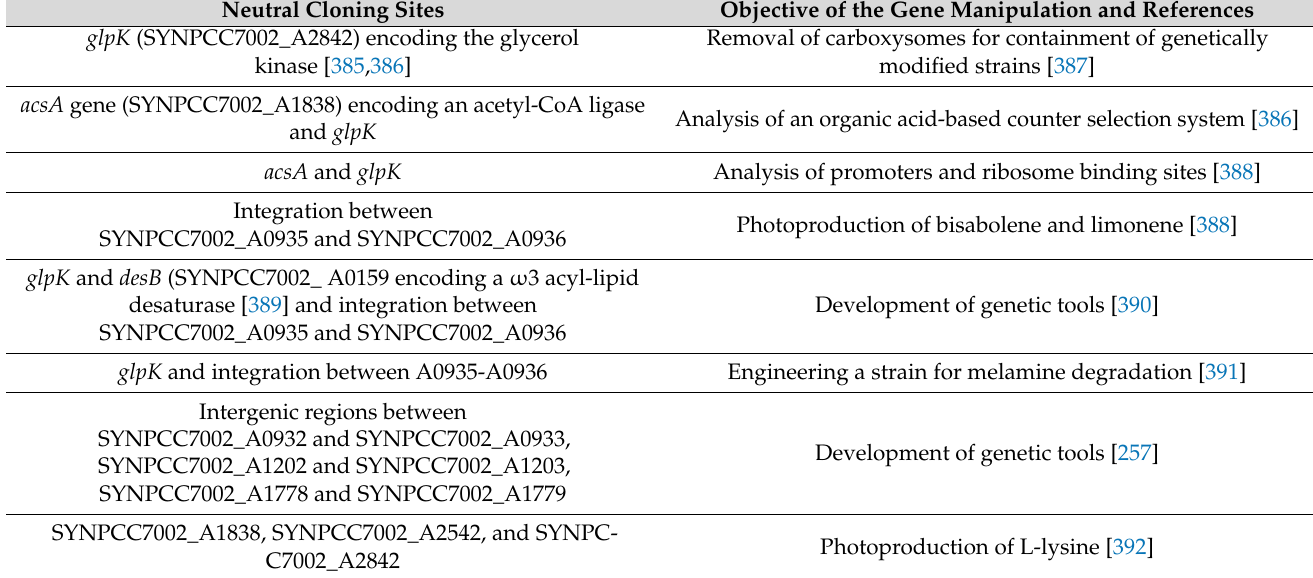
Table 3. Literature on the utilization of chromosomal neutral cloning sites in Synechococcus PCC